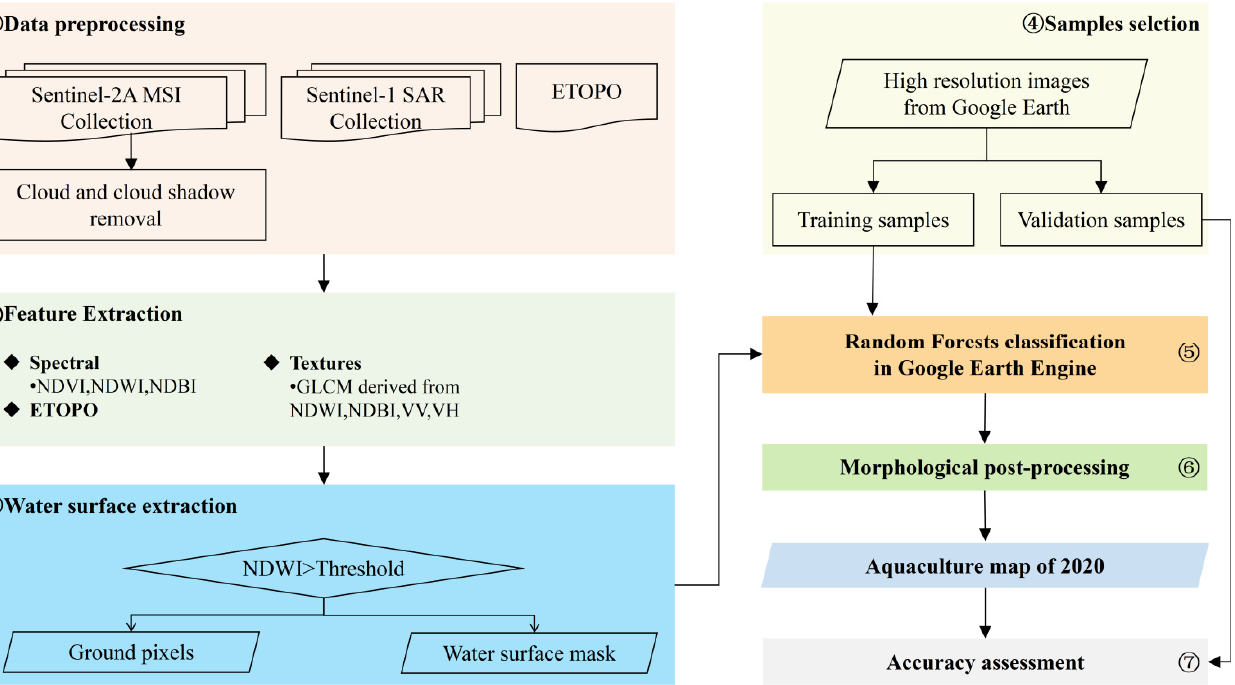
Figure 2. Approach proposed in this study.